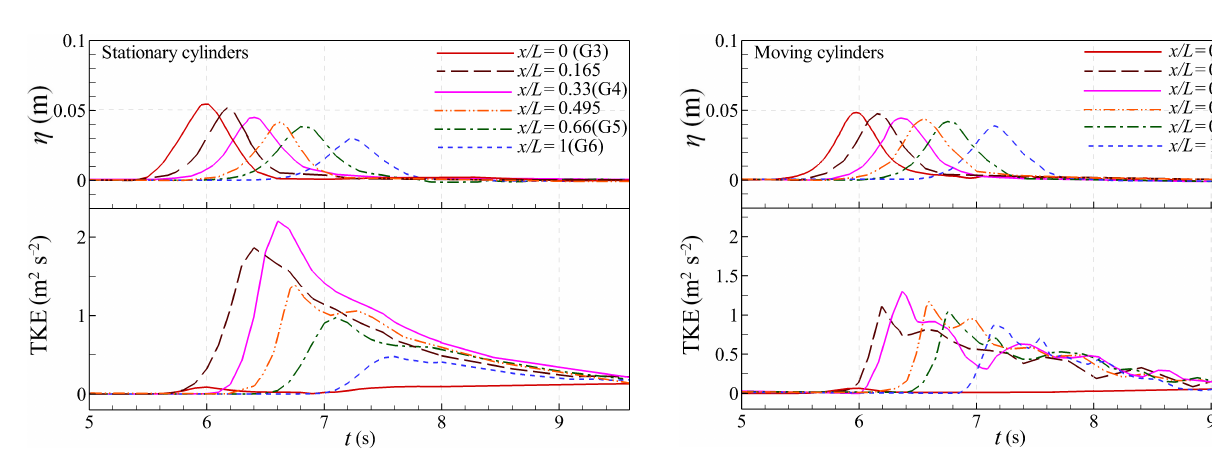
Figure 13. The time evolution of surface elevation and TKE at each section for stationary cylinders, H i = 0.05m.